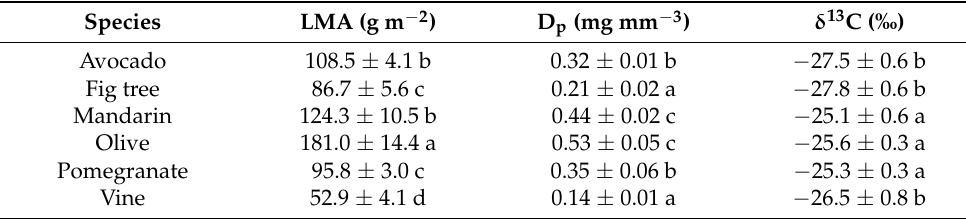
Table 3. Leaf mass per area (LMA), petiole density (D p ), and leaf 13 C isotopic composition ( δ 13 C) of six fruit tree species.